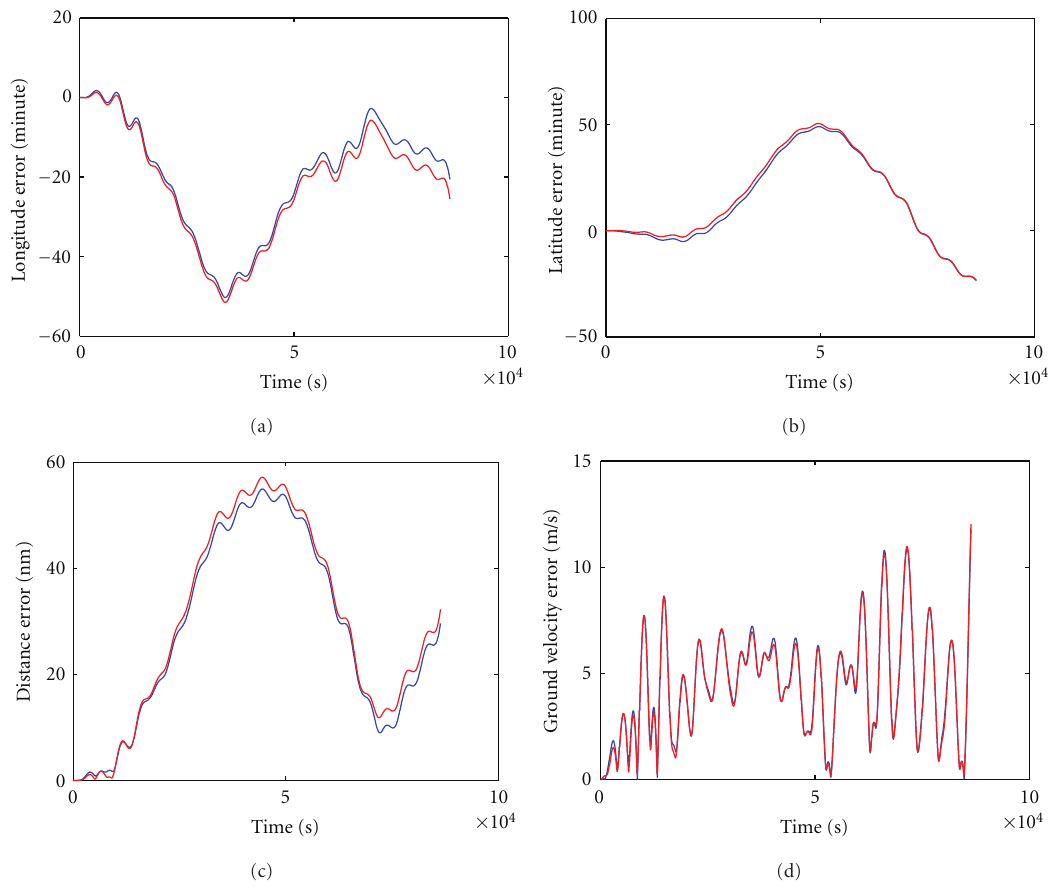
Figure 26: Position and velocity error of real data set